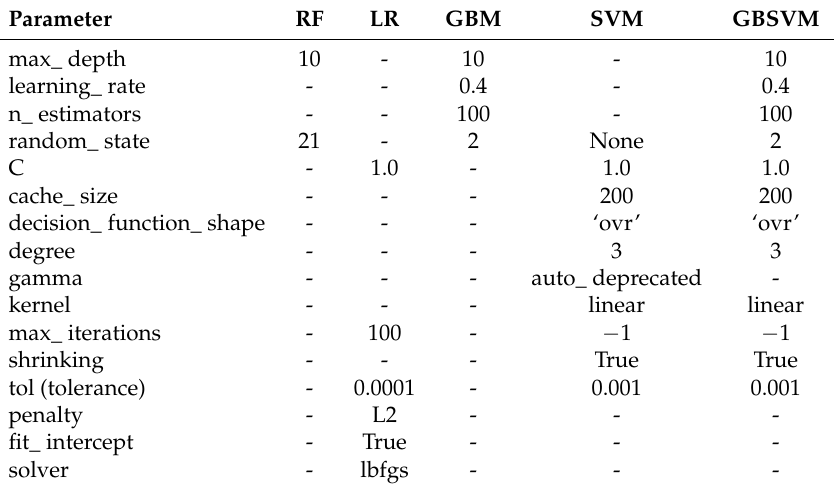
Table 2. Parameters used for classifiers in